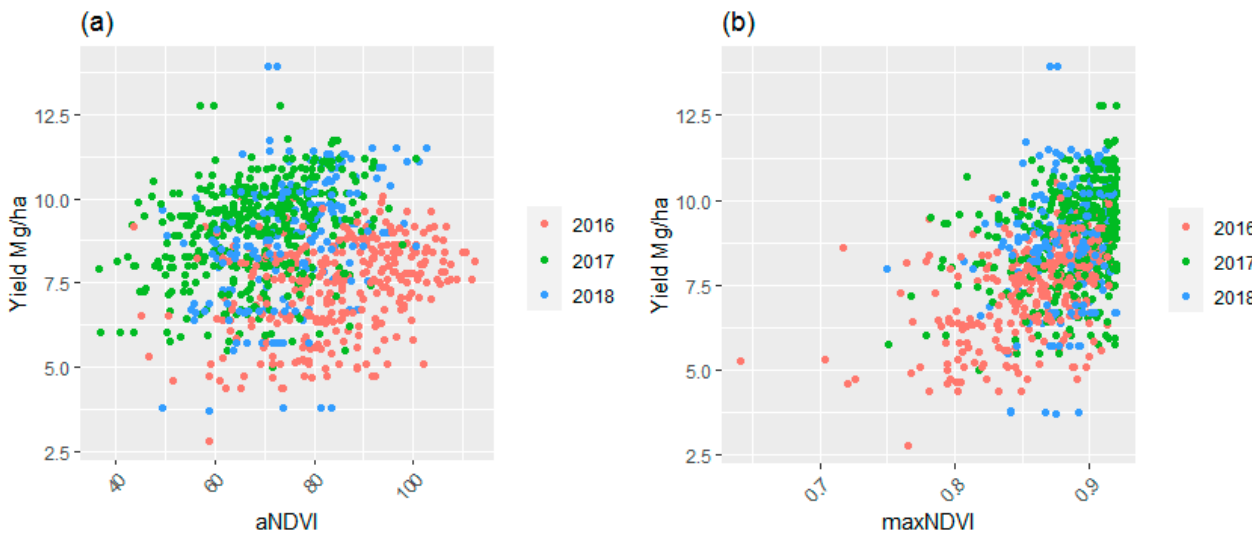
Figure 5. ( a ) Scatterplot of winter wheat yield against aNDVI; ( b ) scatterplot of winter wheat yield against maxNDVI; Color of the points indicate the year of observation (red = 2016, green = 2017 and blue = 2018).